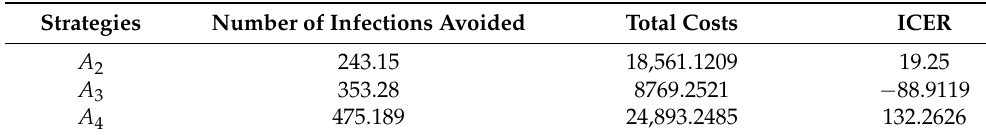
Table 3. Revised comparison of strategic cost table. Strategies Number of Infections Avoided Total Costs